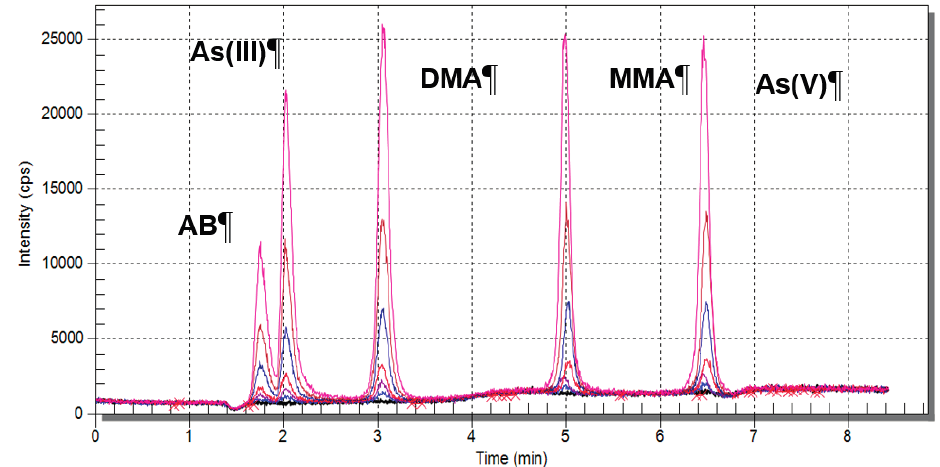
Figure 7. Chromatograms of the arsenic speciation form standard solutions with concentrations of 20 µg/L, 10 µg/L, 5 µg/L, 2 µg/L, 1 µg/L, 0.1